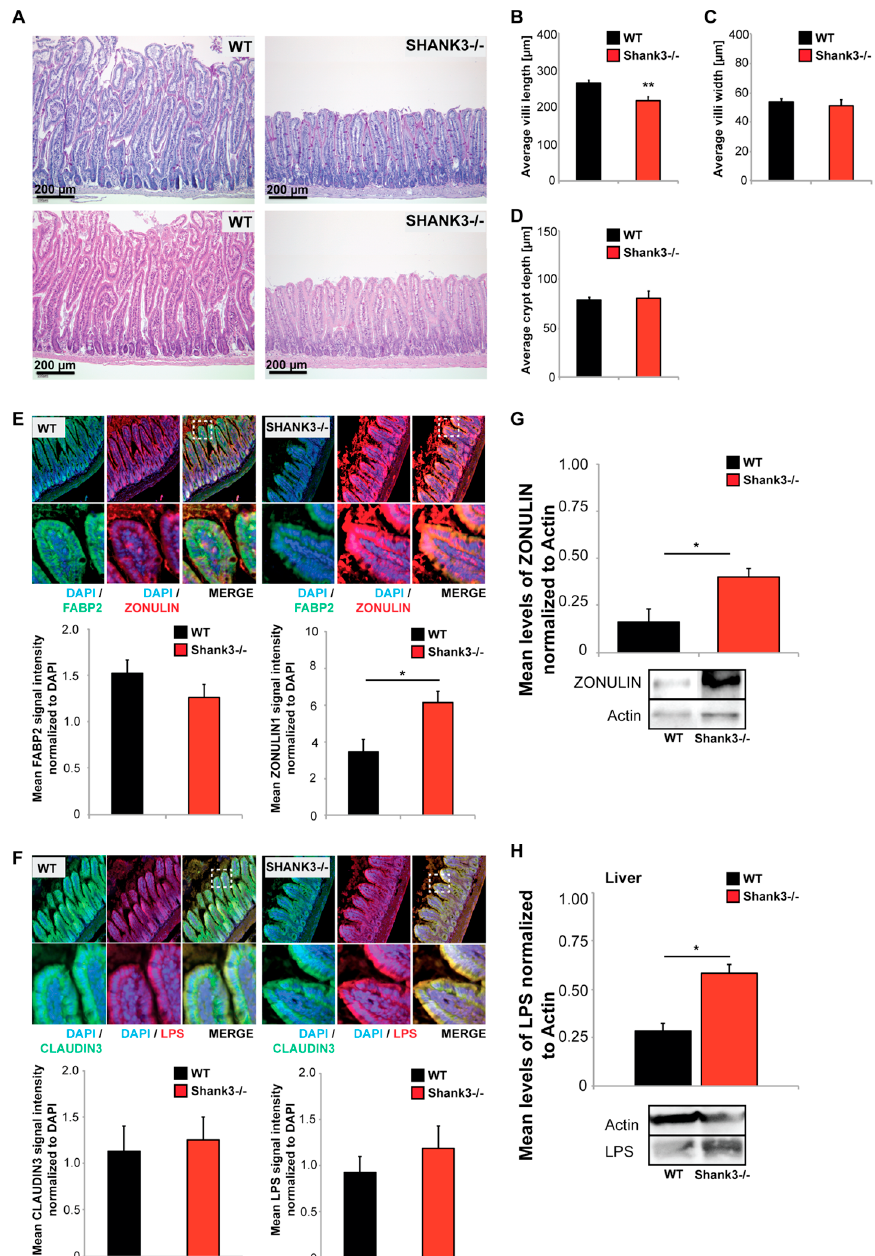
Figure 2. Altered gut morphology in Shank3 αβ knock-out (KO) mice. ( A – D ) Histological evaluation of GI tract from wild type and Shank3 αβ KO mice. ( A ) Longitudinal cross sections of Shank3 αβ KO mice and wild type (WT) mice were stained with hematoxylin / eosin (HE) (upper panels) and periodic acid schi ff (PAS) reaction (lower panels). Exemplary images are shown. ( B – D ) Morphological analysis of ( B ) villi length and ( C ) width, and ( D ) crypt depth reveals a significantly decreased villi length (Mann-Whitney U -test, p = 0.009; n = 5 animals per group) but not width ( p = 0.534), and normal crypt depth ( p = 0.983) in Shank3 αβ KO mice. ( E , F ) Immunohistochemistry was performed on 5 mice per group and 5 optic fields of view each from 3 sections per mouse were analyzed. ( E ) A slight but non-significant decrease in FABP2 signal intensity was observed in Shank3 αβ KO mice compared to wild types (left panel). Significantly higher ZONULIN-1 levels were found in Shank3 αβ KO mice (right panel) ( t -test, p = 0.0413). ( F ) The levels of CLAUDIN3 and lipopolysaccharide (LPS) were not significantly di ff erent between Shank3 αβ KO mice and wild types in gut epithelium. ( G )